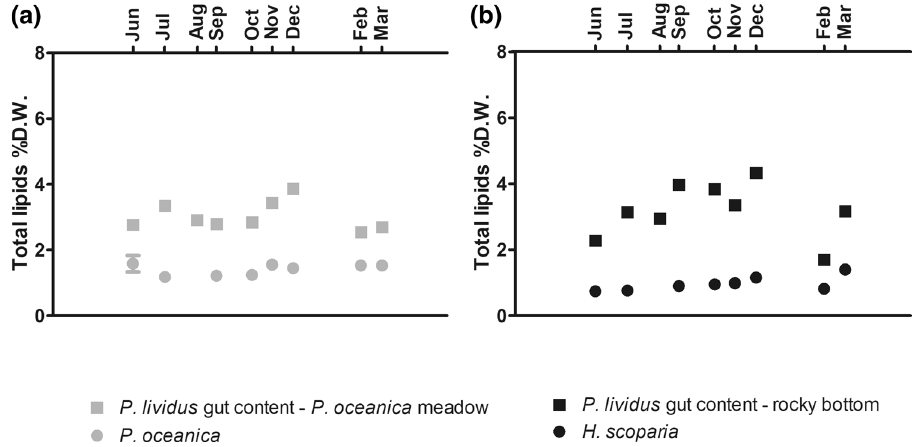
Figure 2. Seasonal variation of total lipids content in P. oceanica and H. scoparia from P. oceanica meadow ( a ) and rocky bottom ( b ), respectively. Each point corresponds to the analysis of a pooled sample, as detailed in “Materials and methods” section.